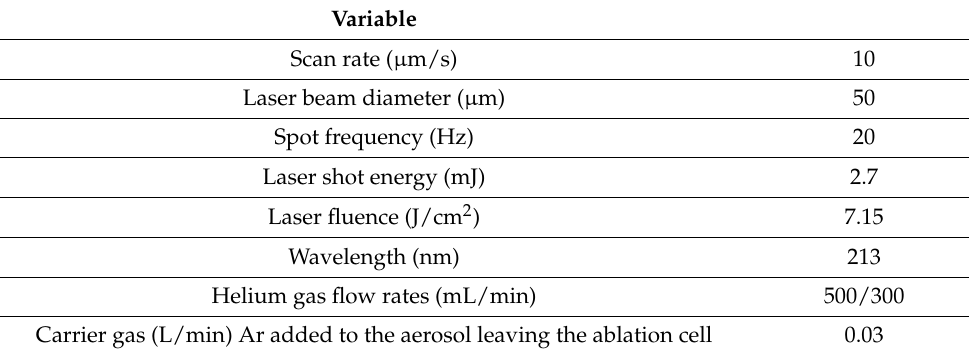
Table 1. Laser ablation operating